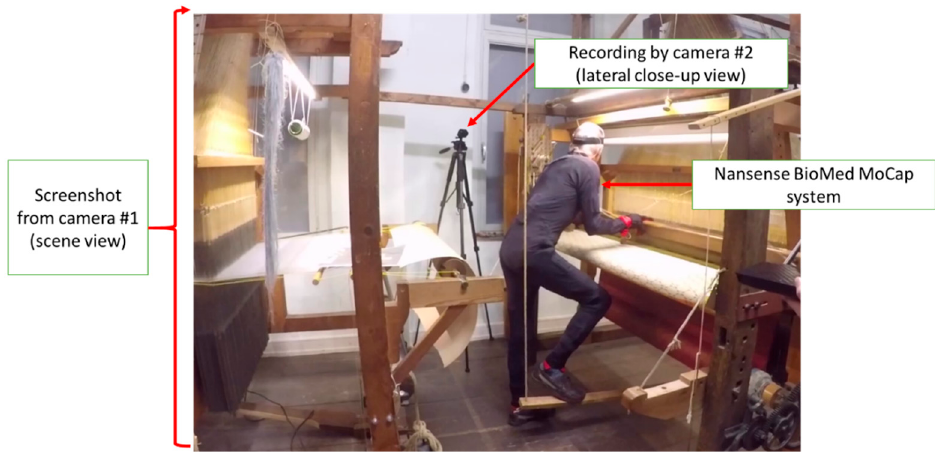
Figure 12. Motion recording setup.